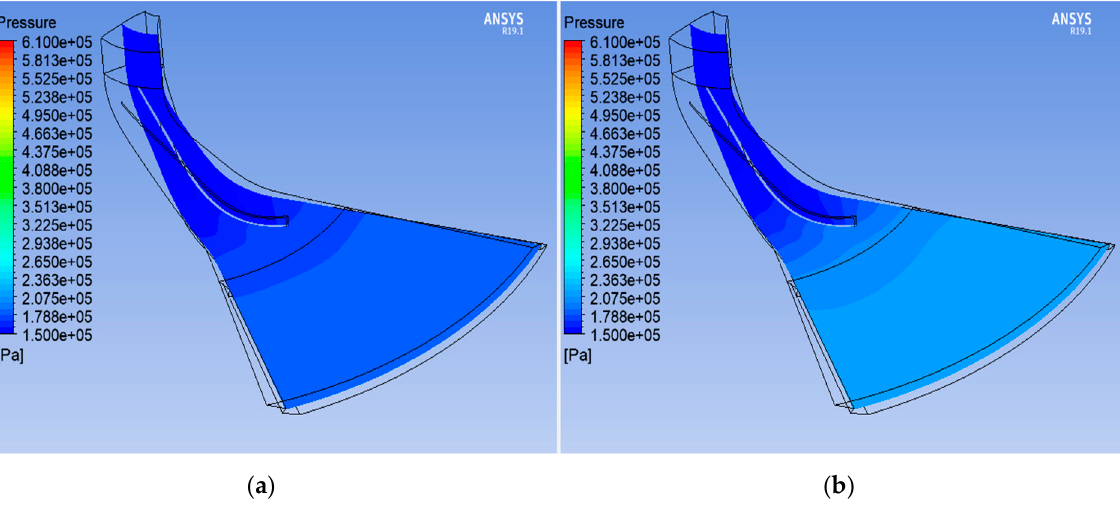
Figure 12. Pressure Contour for R600a at an RPM of 35,000 ( a ) and 40,000 ( b